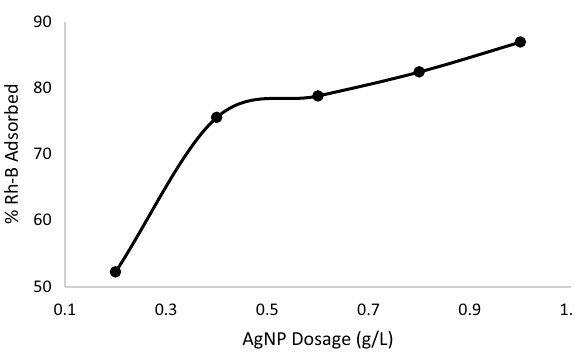
Fig. 5 Percentage removal of Rh-B on AgNPs at different concentra- tions. 1 g/l of AgNPs in 100 ml of 50 mg/l Rh-B, agitation speed— 150 rpm, agitation—30 min at 303 K, pH 3.4